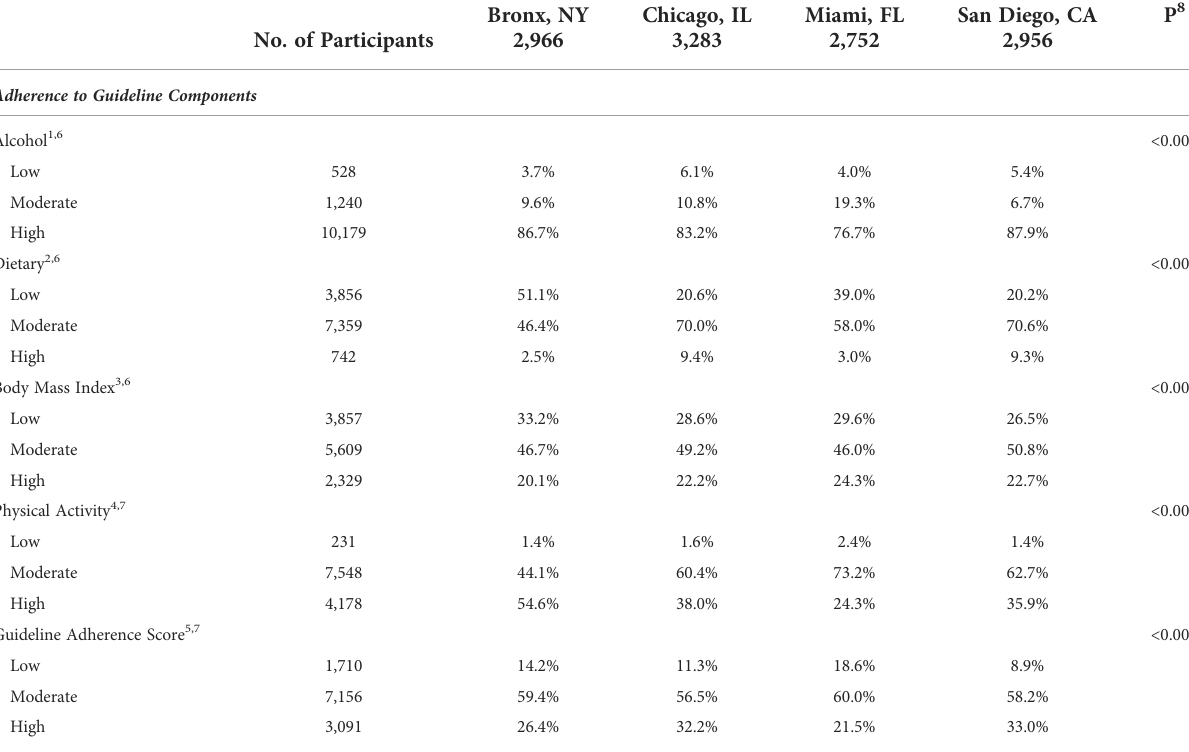
TABLE 5 Proportion of adults meeting the ACS guidelines on nutrition and physical activity for cancer prevention guidelines, by Study Site, N = 11,